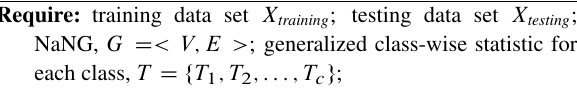
Algorithm 3 NNBCA: Testing